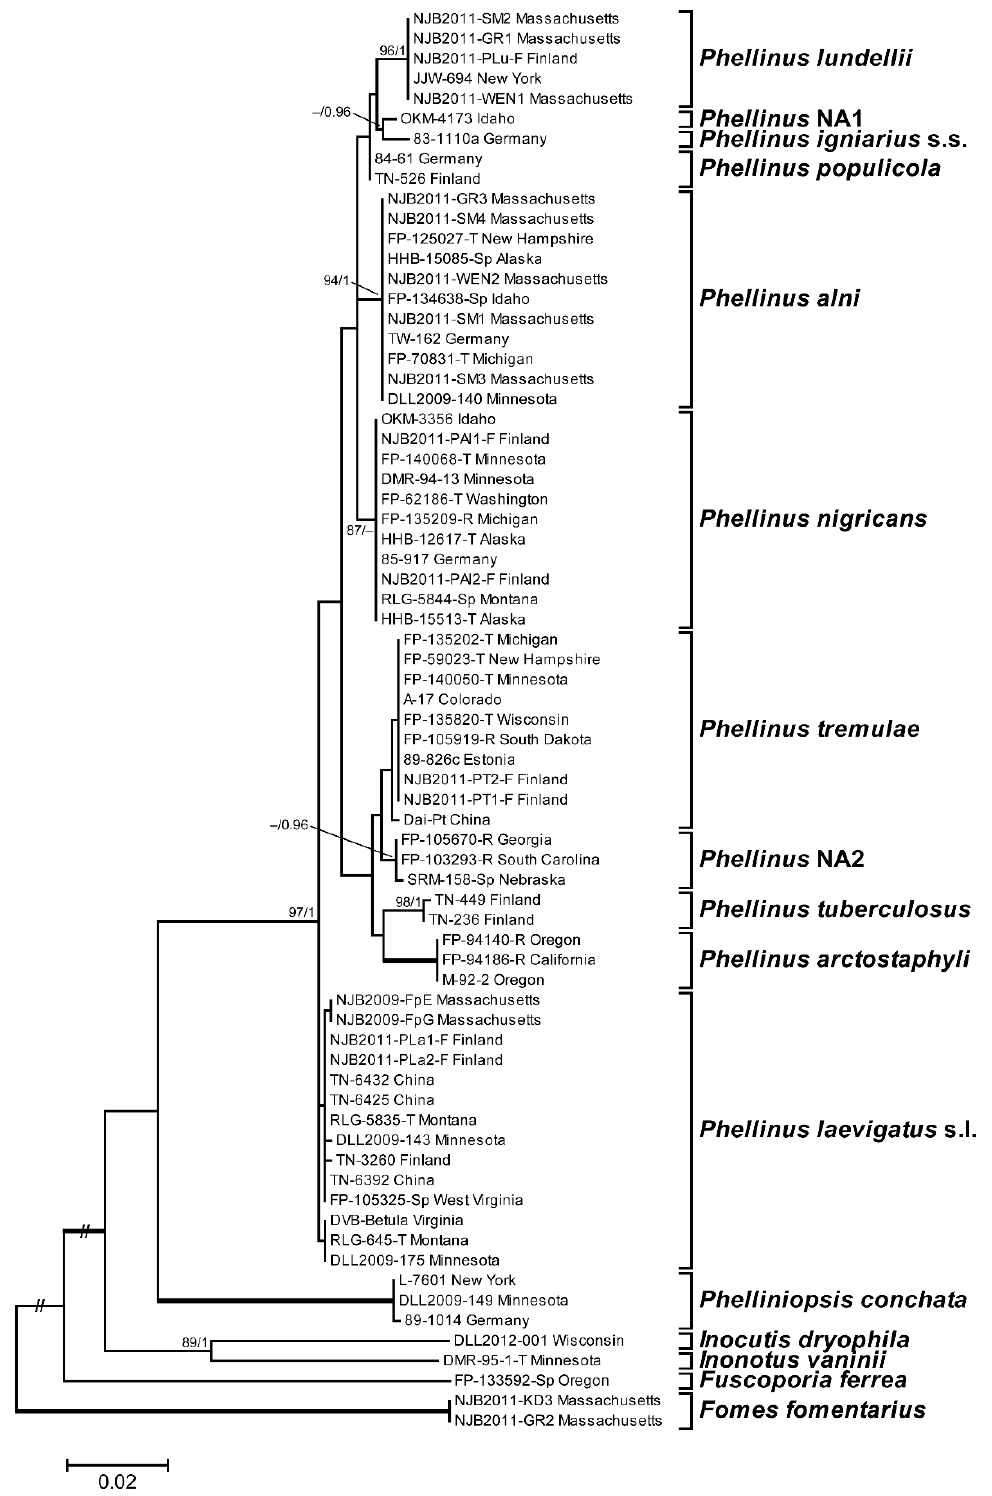
Figure 2. Maximum likelihood tree based on nLSU sequences of Phellinus s.s. species. Bootstrap support values ≥70% and PP values ≥0.95 are shown next to the nodes. Thickened branches represent BS/PP values